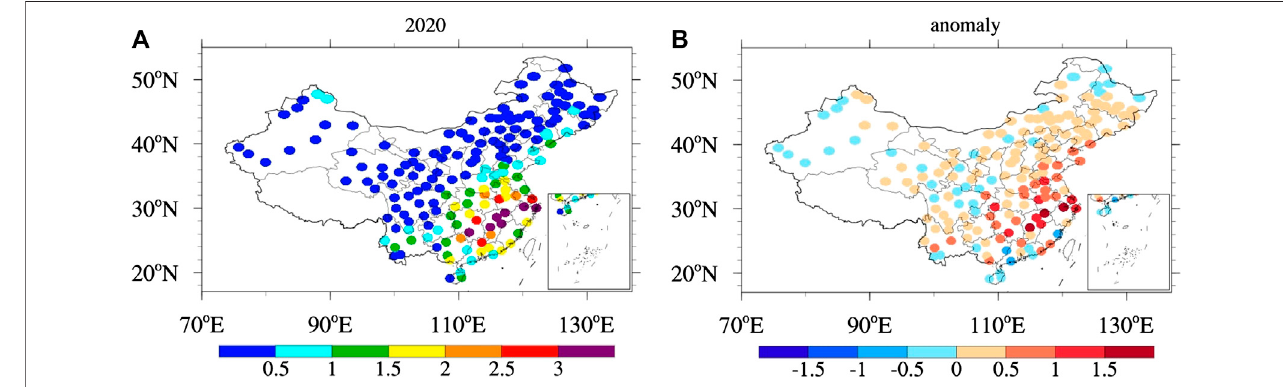
FIGURE2| Timeseriesofprecipitationanomaliesin166observationstationsduringthewinterof1951 – 2020(Unit:mm/day).Theareascontain: (A) allofChina(All: 18 ° – 54 ° N; 72 ° – 135 ° E), (B) north areas in China (North: 34 ° – 54 ° N; 72 ° – 135 ° E), (C) south areas in China (South: 18 ° – 34 ° N; 72 ° – 135 ° E) and (D) the North China (NC: 34 ° – 43 ° N; 110 ° – 119 ° E).